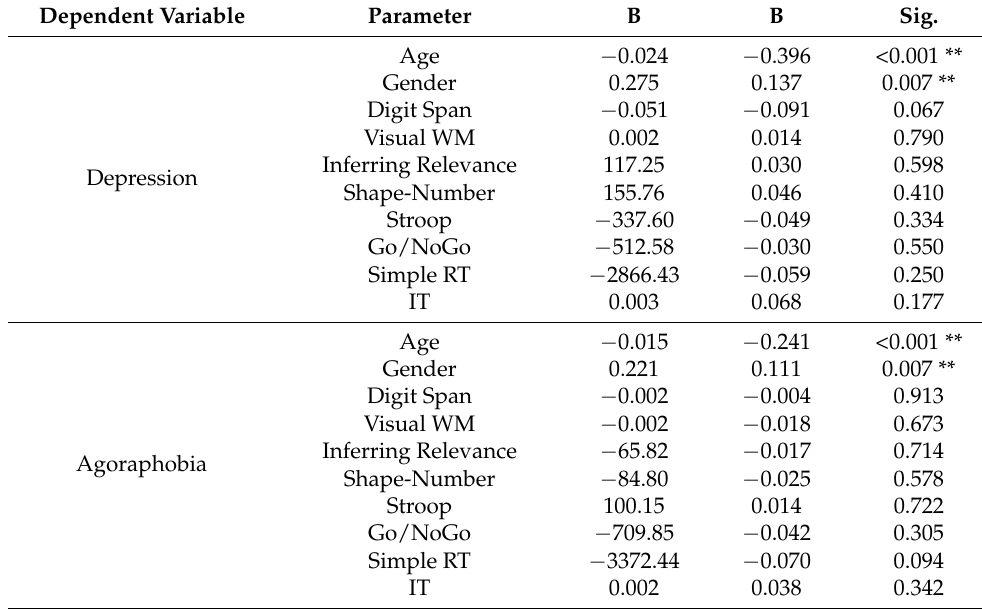
Table 1. Lower-Level Psychopathology Linear Model